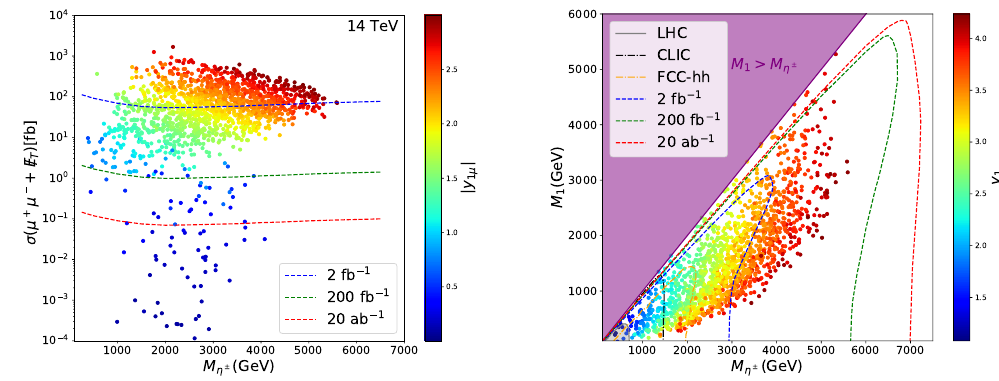
Figure 8 . The 5 σ discovery reaches at the 14 TeV MuC for different luminosity. In the left panel, the discovery limits are obtained by assuming M 1 = M / 2 . In the right panel, we have fixed η ± y 1 e = 0 . 02 , y 1 µ = y 1 τ = 2 and neglected the contribution of N 2 , 3 to derive the discovery limits. The gray region is excluded by LHC [39]. The black and orange lines are the future limits by CLIC and FCC-hh